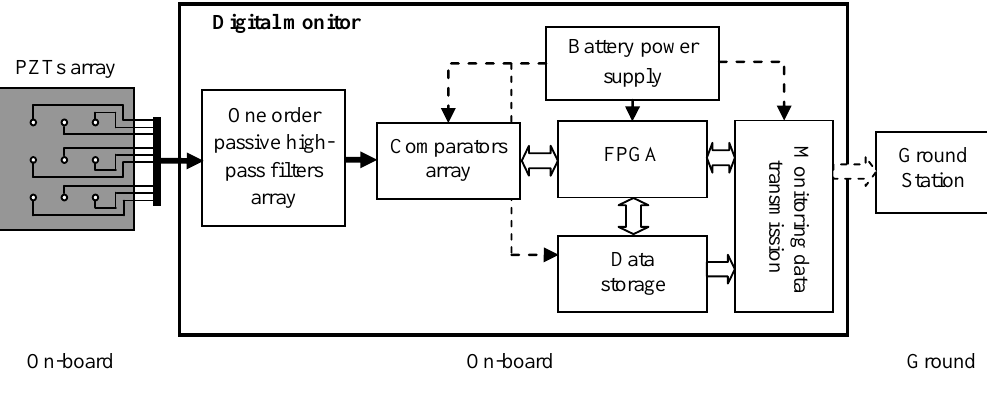
Figure 2. Hardware architecture of the improved digital